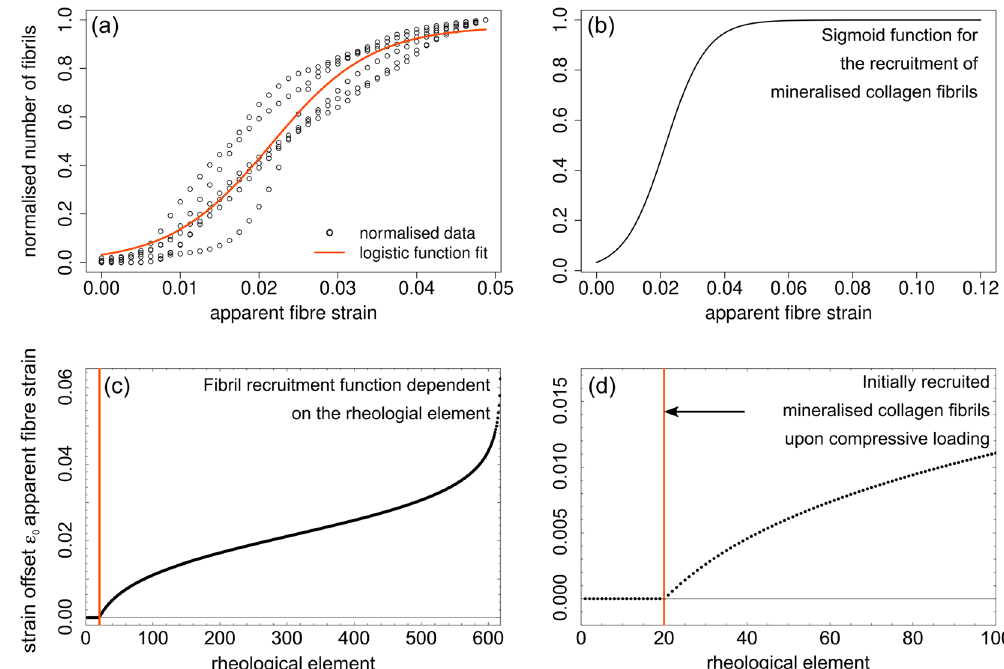
Figure 9. Details to derive the non-linear function for the gradual fibril recruitment. Based on cross- sectional SRnCT slices area fractions relative to the point of full contact between flat punch and micropillar were calculated (Fig. 5). ( a ) Using the fibril diameter and assuming densest packing, a normalised number of fibrils along the loading direction was calculated and fitted with a non-linear function (sigmoid function). ( b ) Extension to cover the full loading range with full contact between 0.05 and 0.12 fibre strain. A plateau is reached after all mineralised collagen fibrils (rheological elements) have been recruited. ( c ) Function curve for the strain offsets ε 0 n for every rheological element n . ( d ) 20 rheological elements are initially